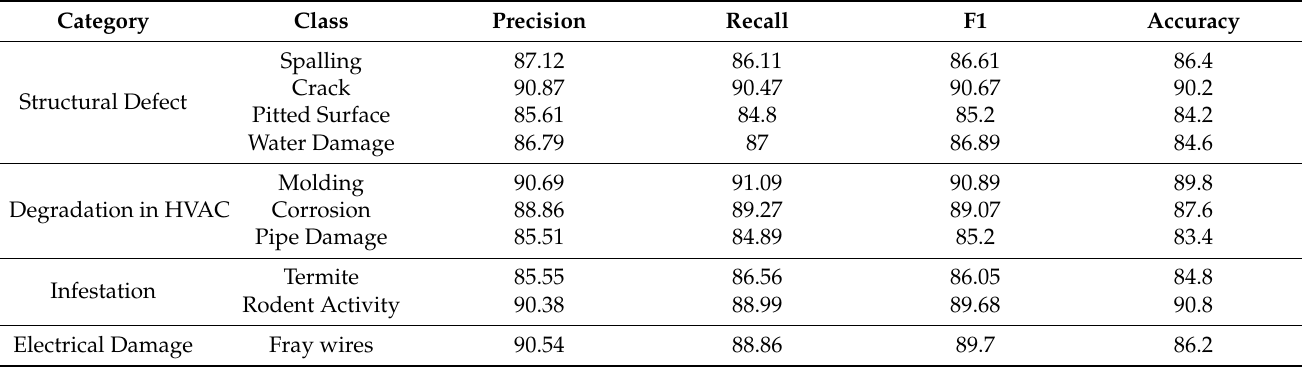
Table 6. Statistical measures for the deterioration detection framework (Faster Resnet 152).